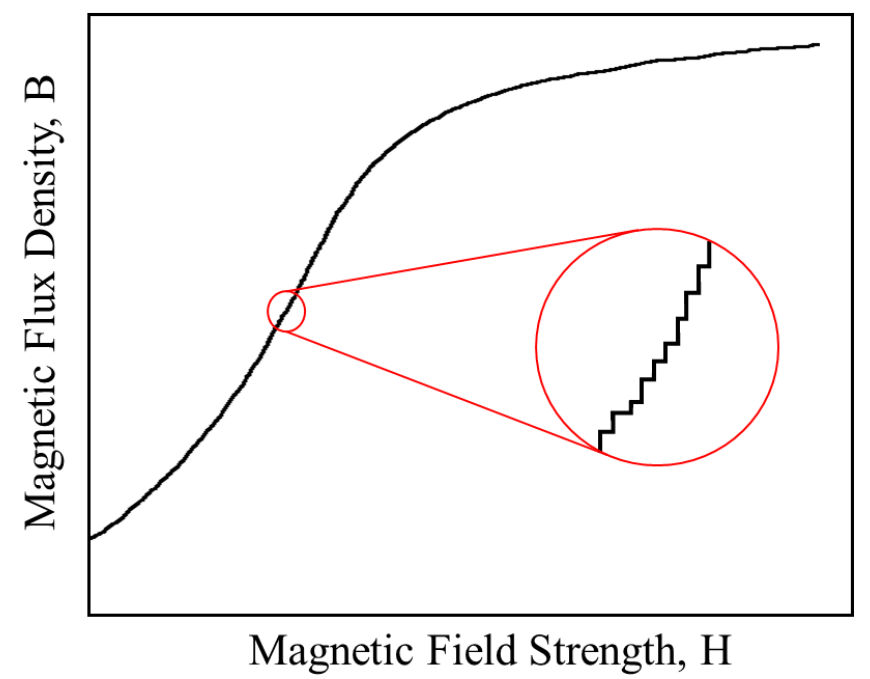
Figure 5. Magnetic Barkhausen noise, as illustrated by irreversible discontinuities in the magnetization, M, as the alternative current magnetic field, H, is varied (adapted from Reference [71]).